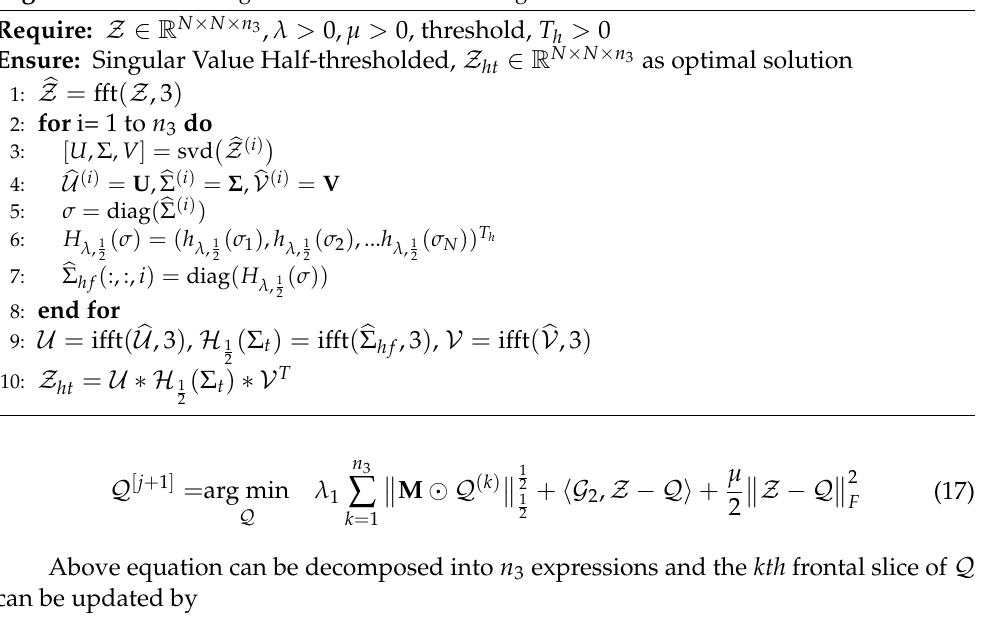
Algorithm 1 Tensor singular value half